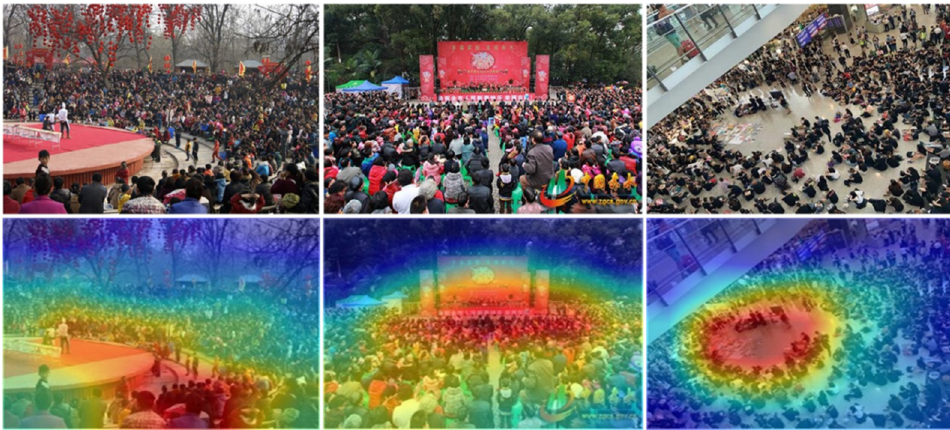
Figure 11. Visualization results of some images in the GPIAD dataset after MAN. The first and second lines show the nature image and results of visualization, respectively. lines show the nature image and results of visualization, respectively.